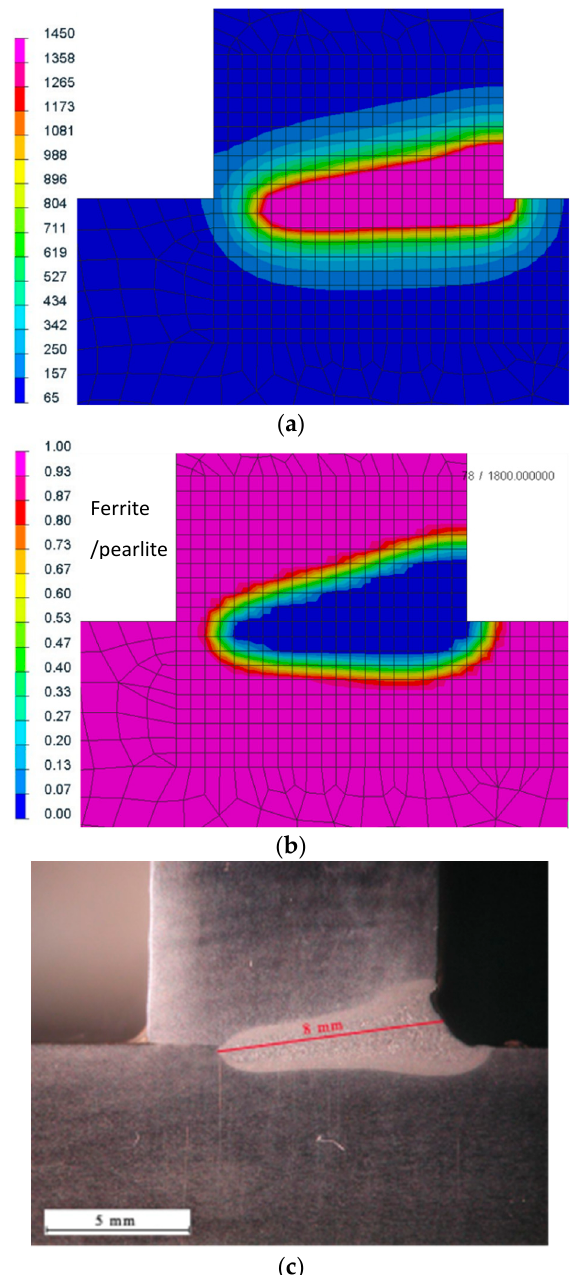
Figure 4. Laser welding ( a ) temperature field distribution, and comparison of ( b ) a ferrite/pearlite as an initial phase distribution with (c) a macro-section of a welded joint (the blue color is the estimated melted zone/weld area; cross-sections were made in the half-length of the joint).